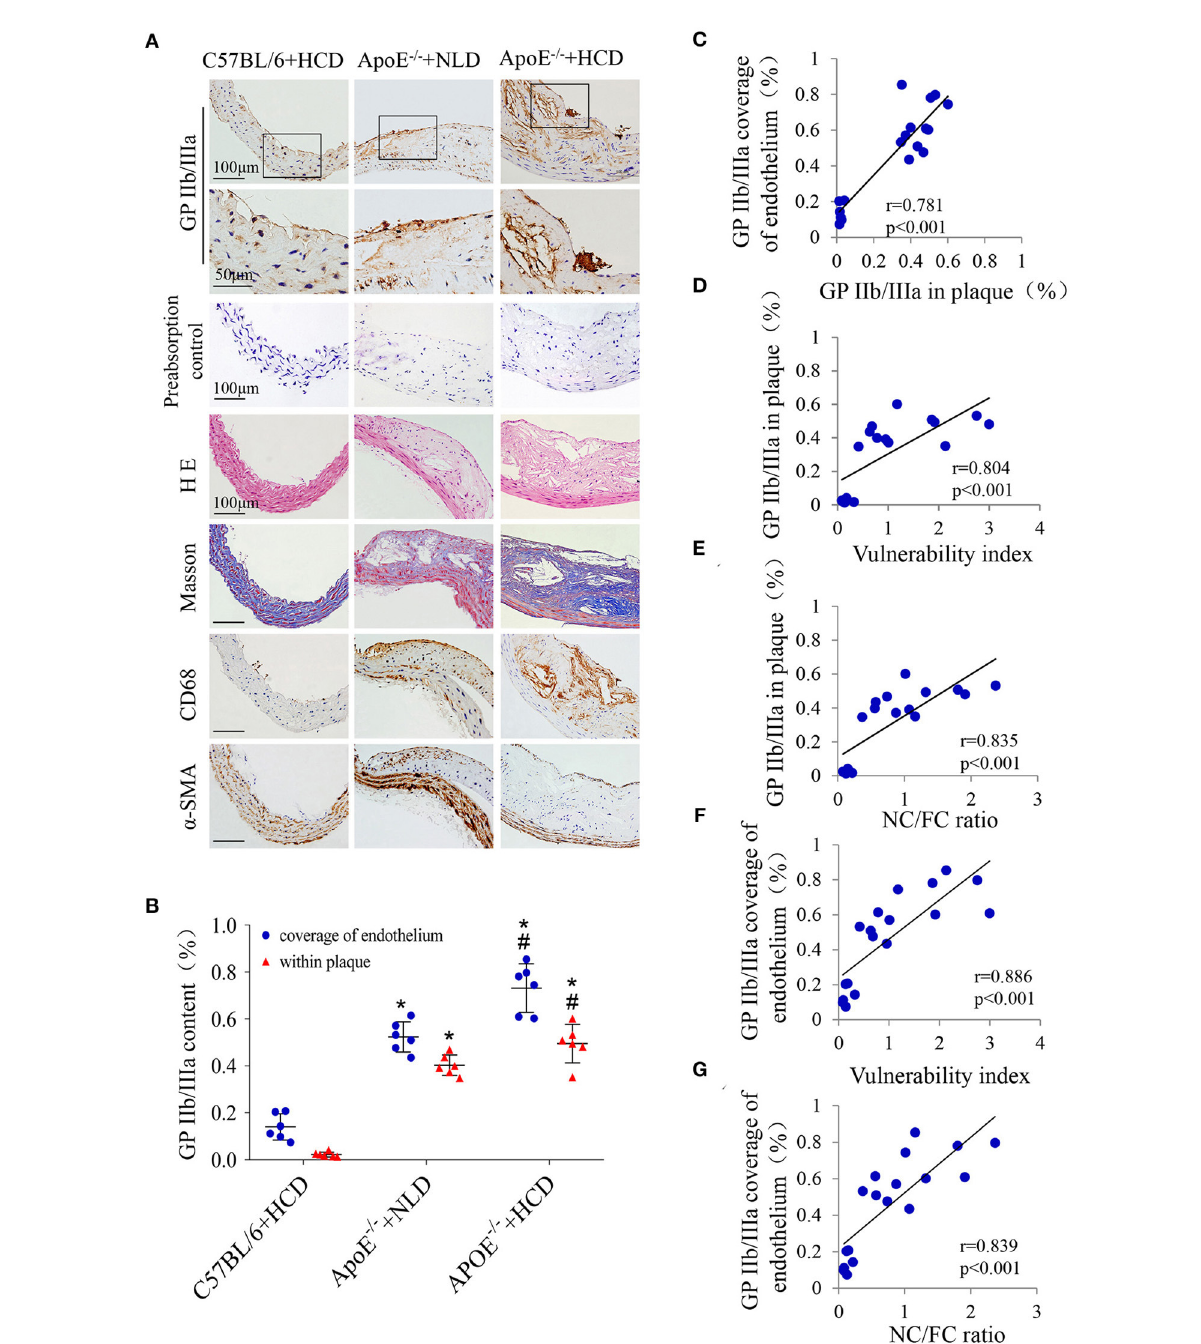
FIGURE2 Correlations between GP IIb/IIIa expression and the plaque vulnerability indicators. (A) Representative images of aortic tissue visualized by H & E and Masson’s trichrome staining or labeling with antibodies against GP IIb/IIIa, α -SMA and CD68 are shown. The primary antibody was substituted with the GP IIb/IIIa antigen-antibody complex as a preabsorption negative control. (B) The GP IIb/IIIa content in total plaque and coverage of the endothelium were quantified. Correlations between GP IIb/IIIa expression in plaques and (C) GP IIb/IIIa coverage of the endothelium, (D) plaque vulnerability index and (E) NC/FC ratio; and between GP IIb/IIIa coverage of the endothelium and (F) plaque vulnerability index and (G) NC/FC ratio were determined. n = 6 per group. Data represent the mean ± standard deviation. * P < 0.05 vs. C57BL/6 + HCD, # P < 0.05 vs. ApoE − / − + NLD. α -SMA: α -smooth muscle actin; NC/FC: necrotic center/fiber